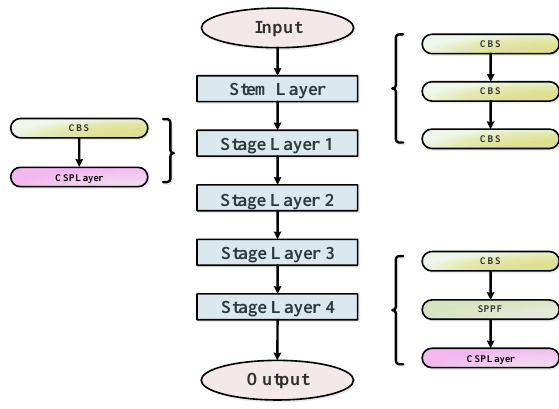
Figure 4. The overall structure of the backbone.